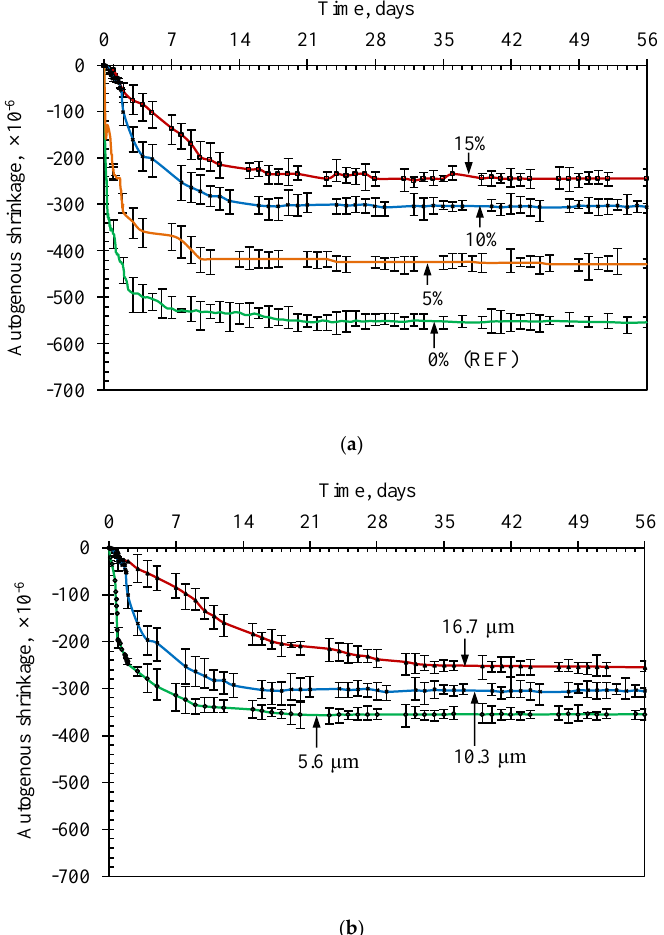
Figure 10. Effect of the zeolite content ( a ) and the particle size of zeolite ( b ) on autogenous shrinkage of HPC specimens — measurements were performed on 3 replicates.